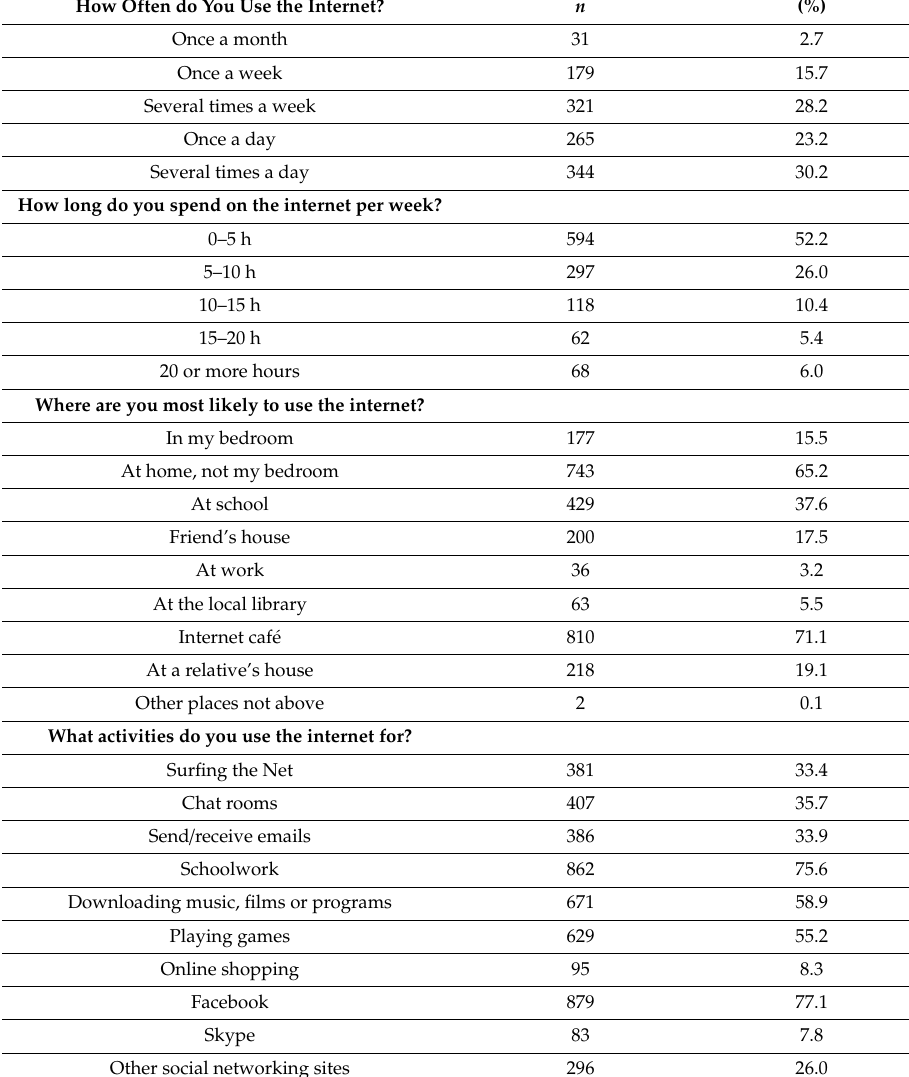
Table 1. Numbers and percentages for scores of internet use (total n =